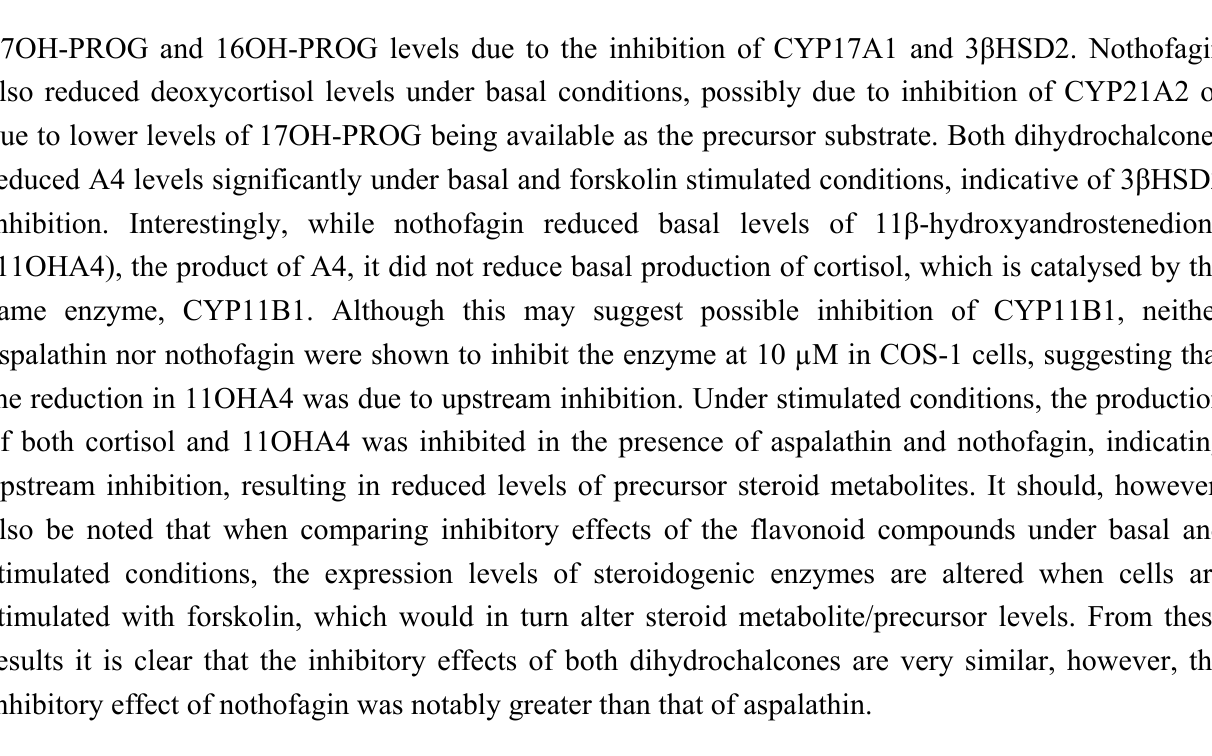
Table 2. Steroid metabolites produced in adrenal H295R cells under basal and forskolin (10 µM) stimulated conditions in the absence and presence of selected flavonoids (10 µM) after 48